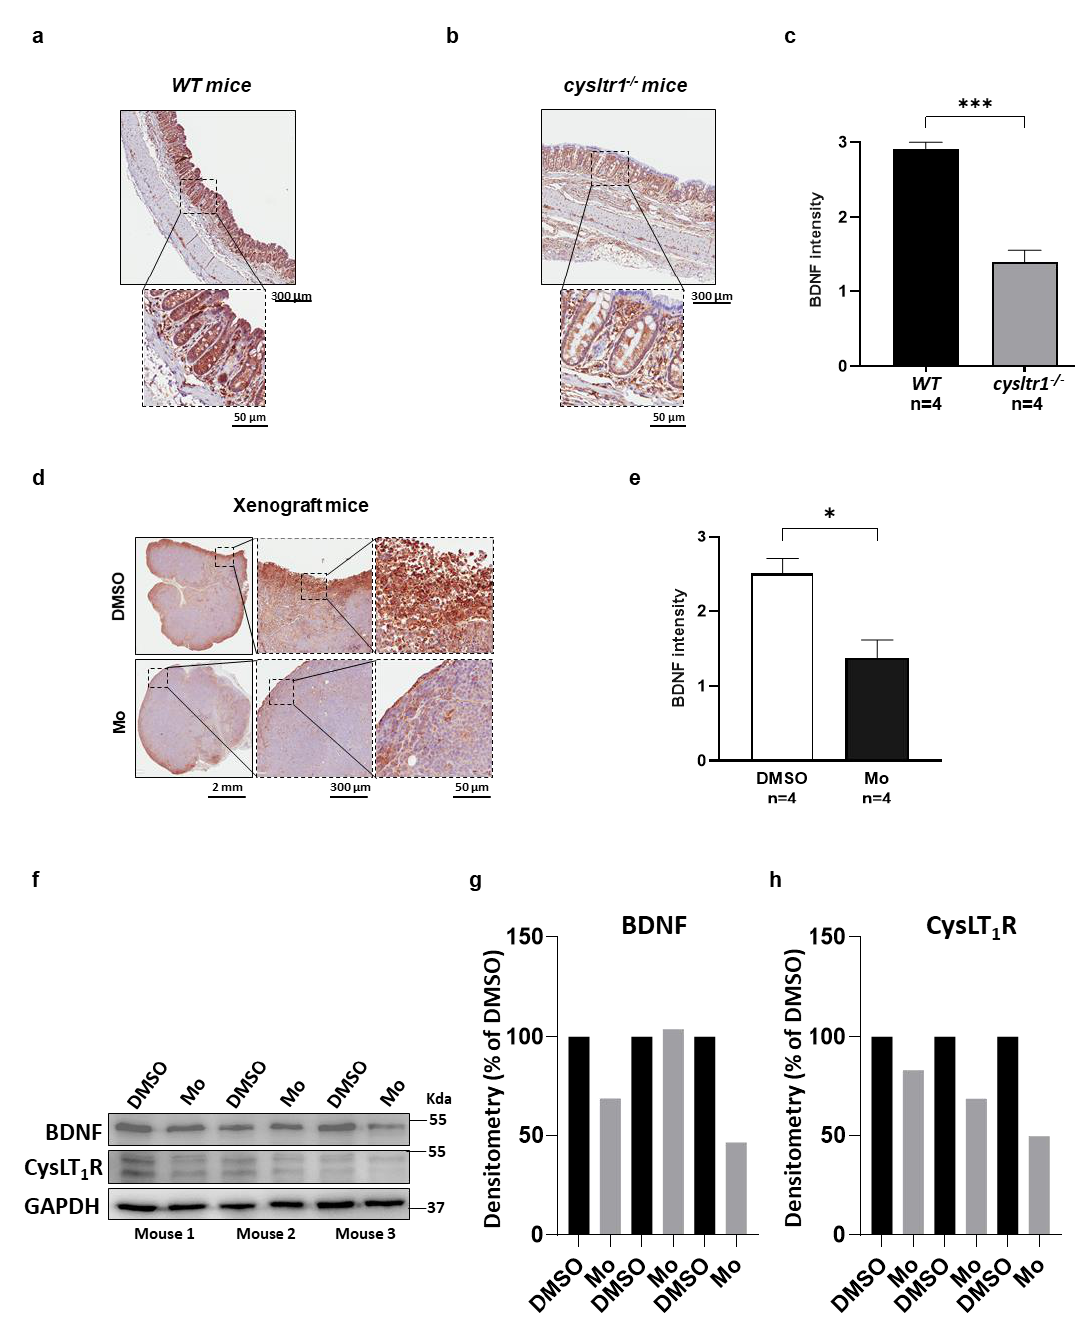
Figure 3. Functional absence of CysLT 1 R negatively regulates BDNF expression. BDNF protein expression in mouse colon tissues of colitis-associated carcinoma (CAC; AOM/DSS-treated) mice. Immunohistochemistry evaluation in colon sections were performed by evaluating six random areas in the whole colon. Representative images (8× and 40× magnification) showing one out of six areas from ( a ) wild-type ( WT ) mice ( n = 4) and ( b ) cysltr1 gene disruption ( cysltr1 −/− ) mice ( n = 4) and ( c ) the corresponding bar diagram showing BDNF intensity. ( d ) The mice xenograft sections were evaluated for BDNF intensity. Representative images showing the mouse xenograft section for the group treated either with vehicle control (DMSO) or the CysLT 1 R antagonist, Montelukast (Mo), and ( e ) the corresponding bar diagram. Western blot and densitometry analyses of BDNF ( f , g ) and CysLT 1 R ( f , h ) protein expression in mice xenograft tumor tissues from DMSO vehicle control or Mo treated mice. Scale bars as indicated in the images. * p < 0.05, *** p < 0.001.